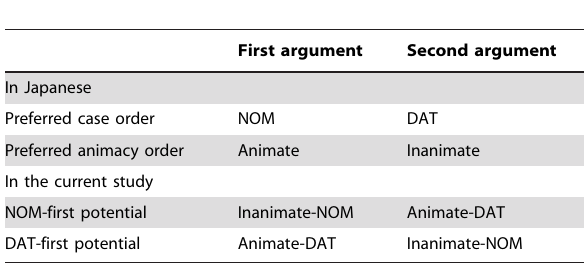
Table 1. Patterns of case marking and